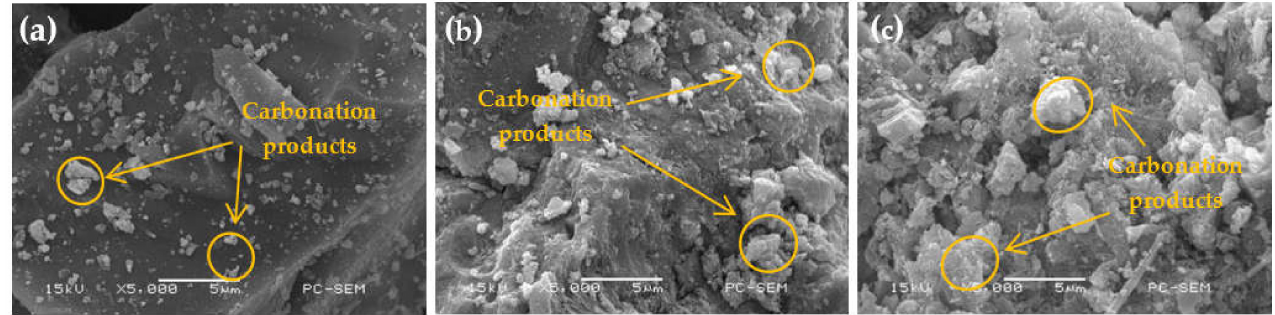
Figure 10. SEM images of RAC-2-75 carbonized for 28 days after different freeze–thaw cycles: ( a ) 200; ( b ) 400; ( c ) 600.